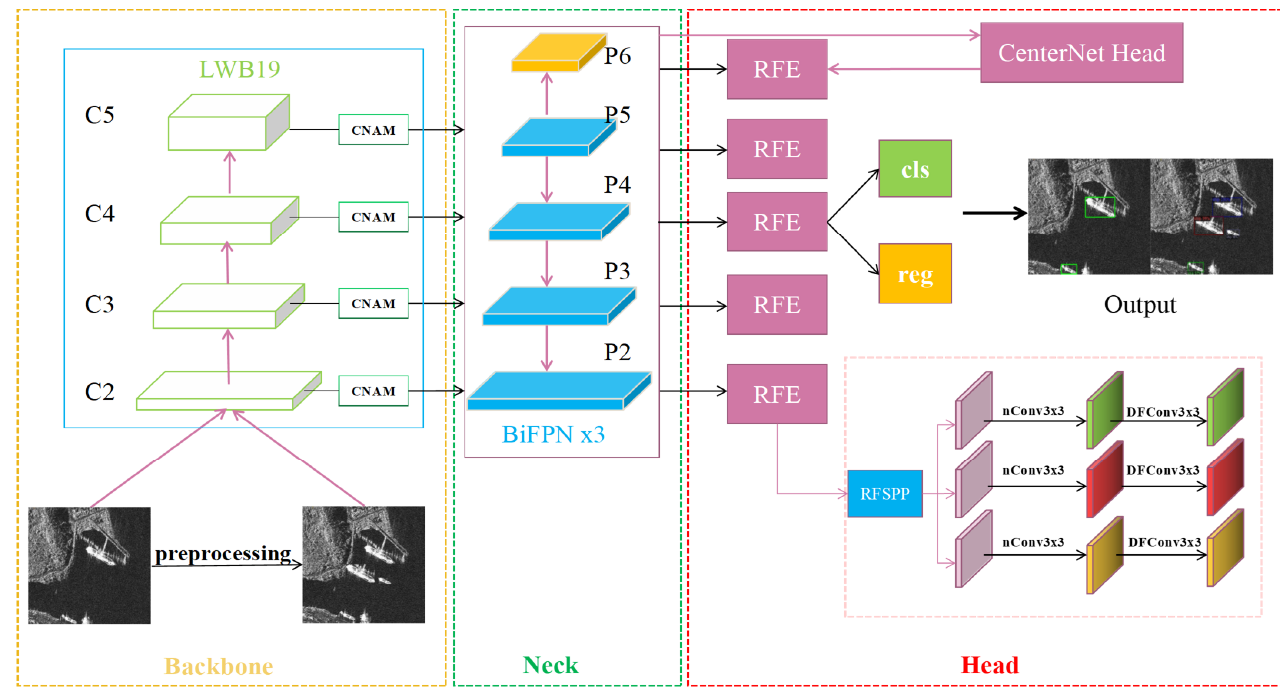
Figure 1. Overall architecture of SRDet. Preprocessing refers to performing data augmentation considering semantic relationships on the original image; LWB19 represents our designed lightweight backbone LWBackbone, which includes only 19 convolutional layers; CNAM represents our proposed attention module; and RFE represents our proposed augmented detection head module.